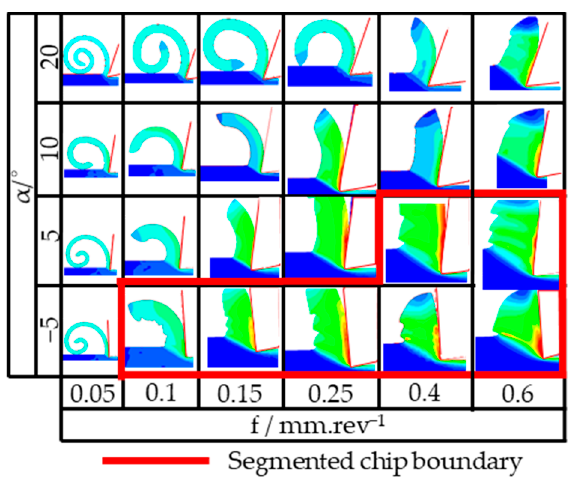
Figure 10. Continuous chip to segmented chip transition prediction predicted by the MJC flow stress model in combination with the Autenrieth Fracture initiation strain model. Note: Image magnification not to scale.